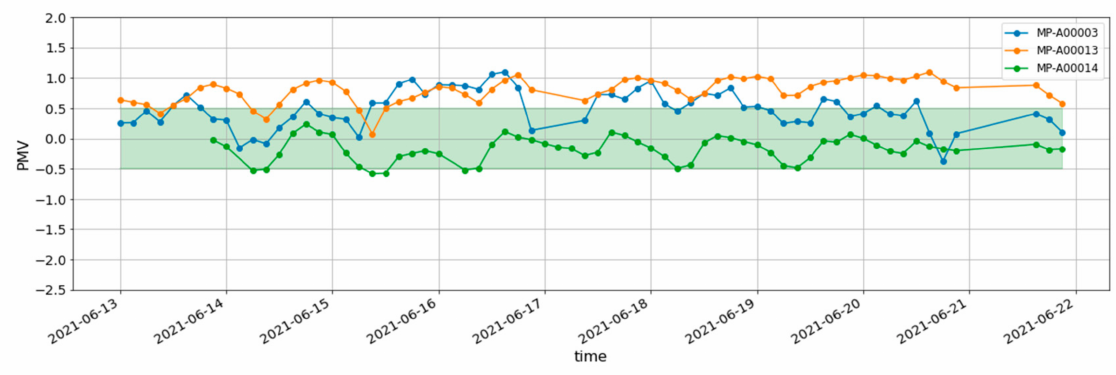
Figure 19. PMV values for the three platforms in summer (June).